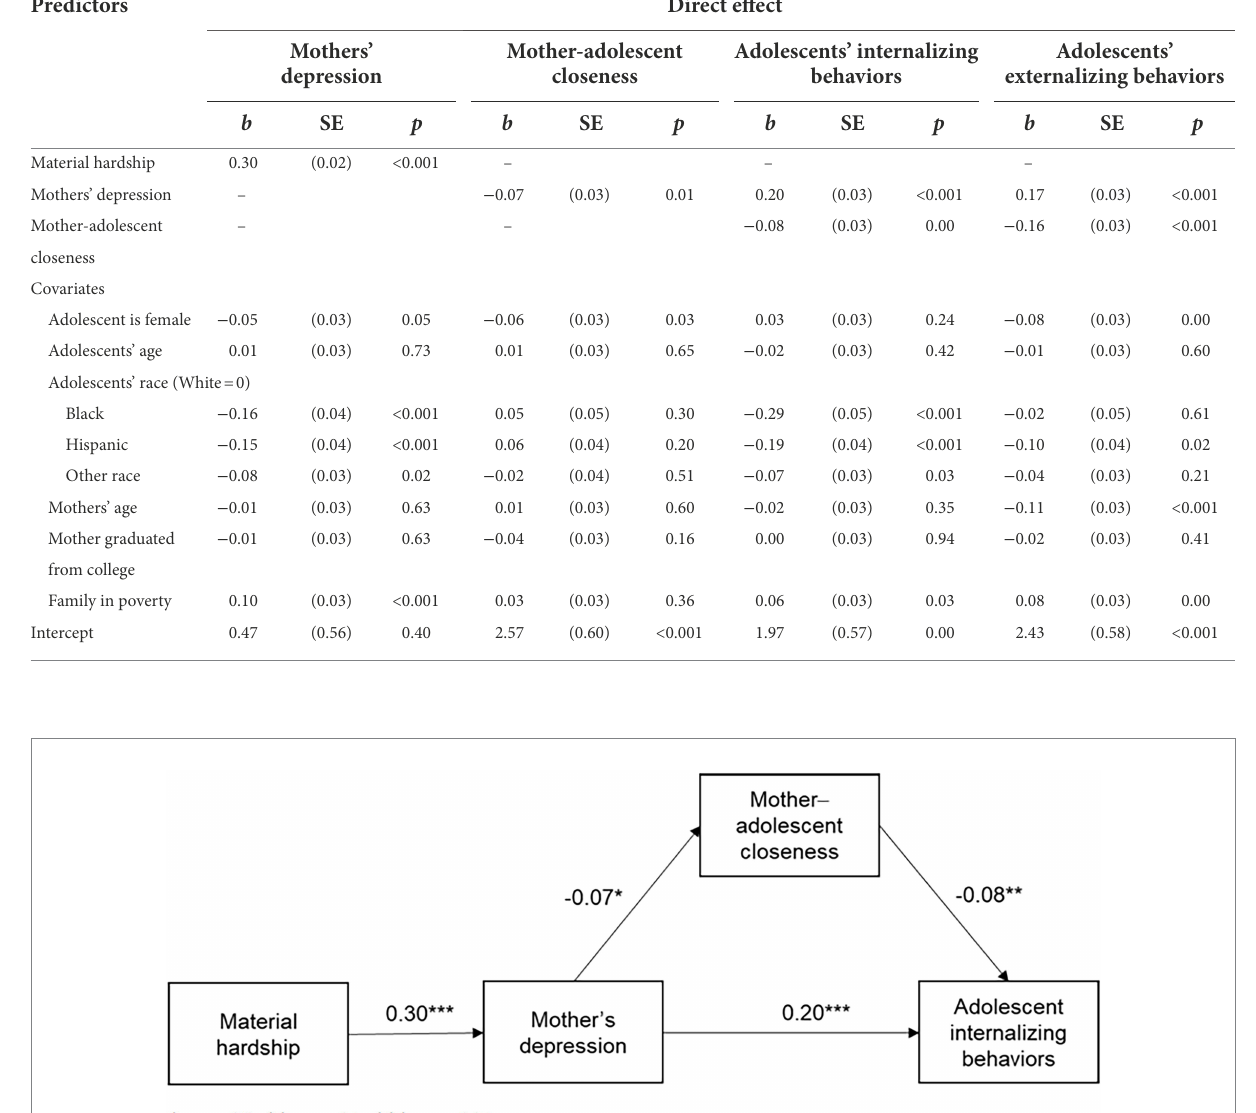
TABLE 3 SEM Standardized coefficient estimates ( N = 1,384).